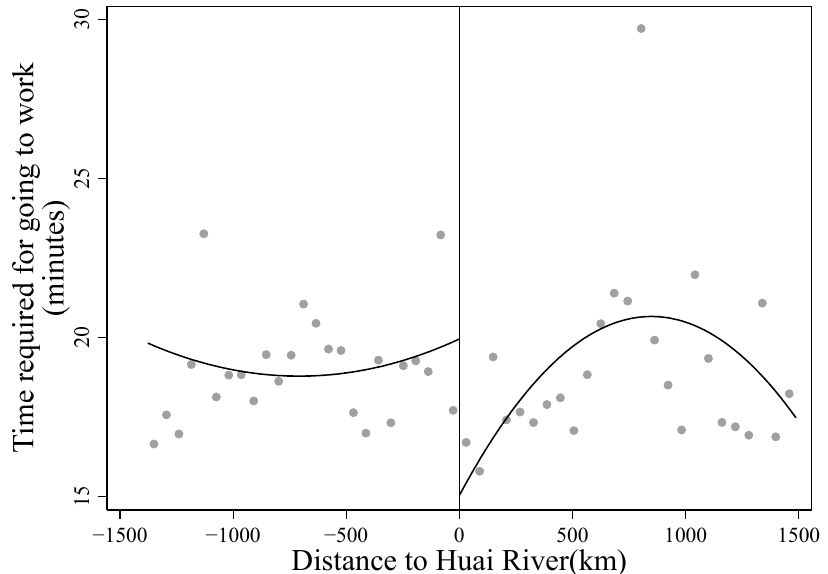
Figure A2. RD plot for the time required for going to work. Notes: The figure shows the binned averages of the time required for going to work against the running variable. The solid line represents a quartic polynomial fit of time on each side of the threshold.